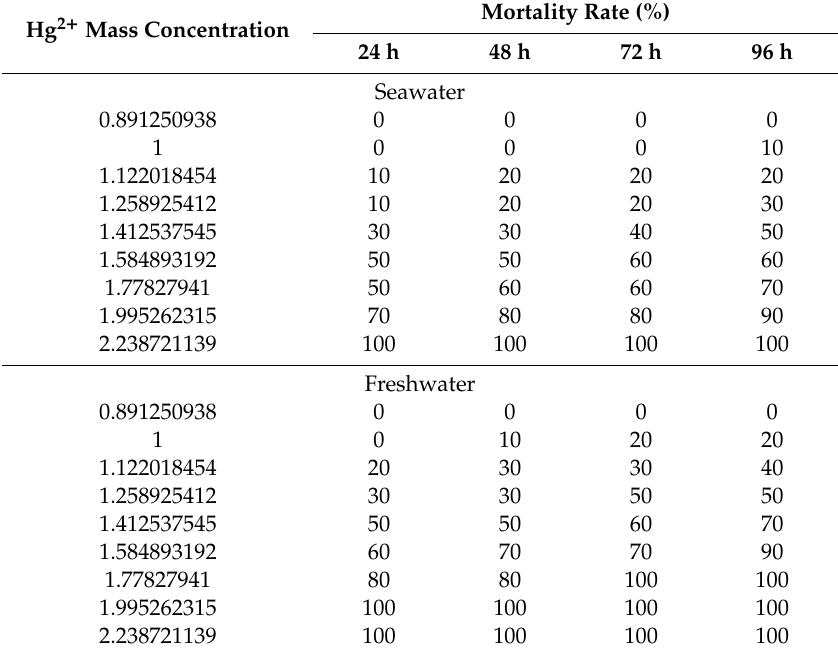
Table 1. Divalent mercury ion mass concentrations and mortality rates of Anguilla